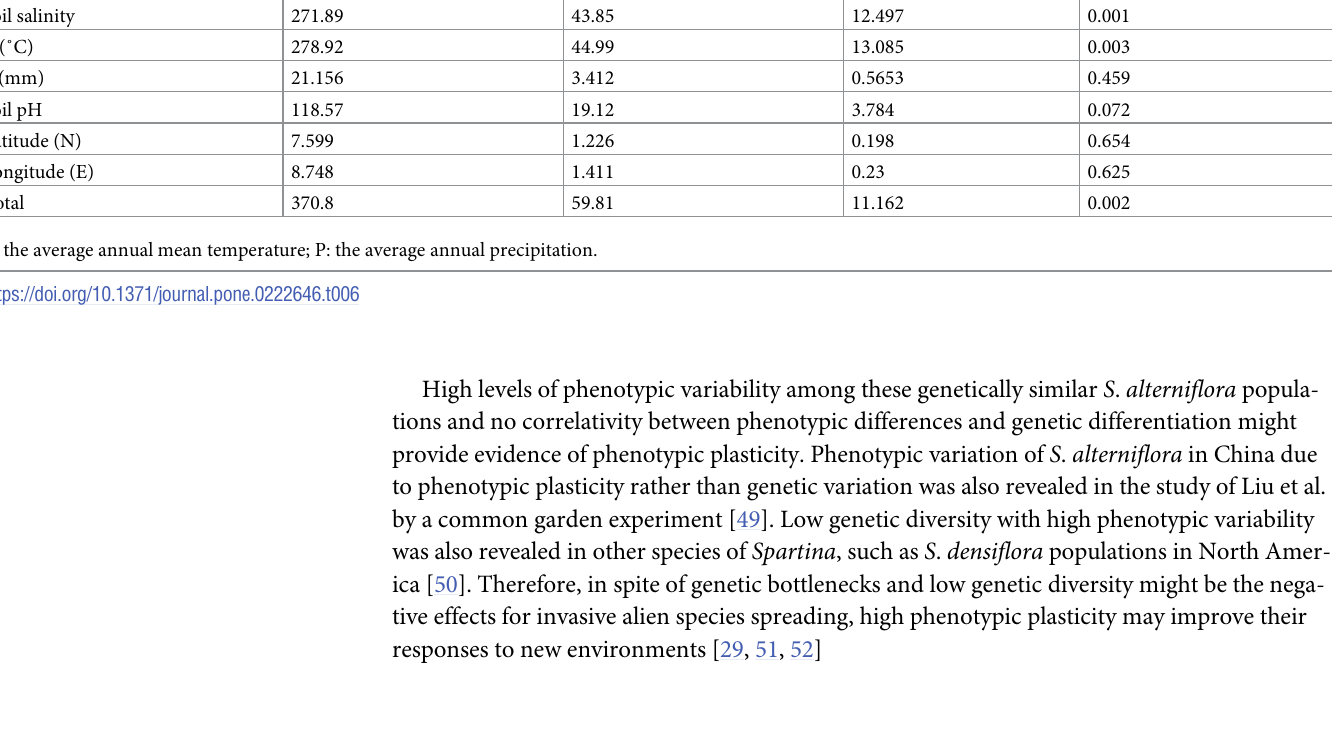
Table 6. A redundancy analysis (RDA) of the phenotypic and environmental/geographic variables in population 1-BJ, 4-QS, and 5-XC. Environmental/ Geographic